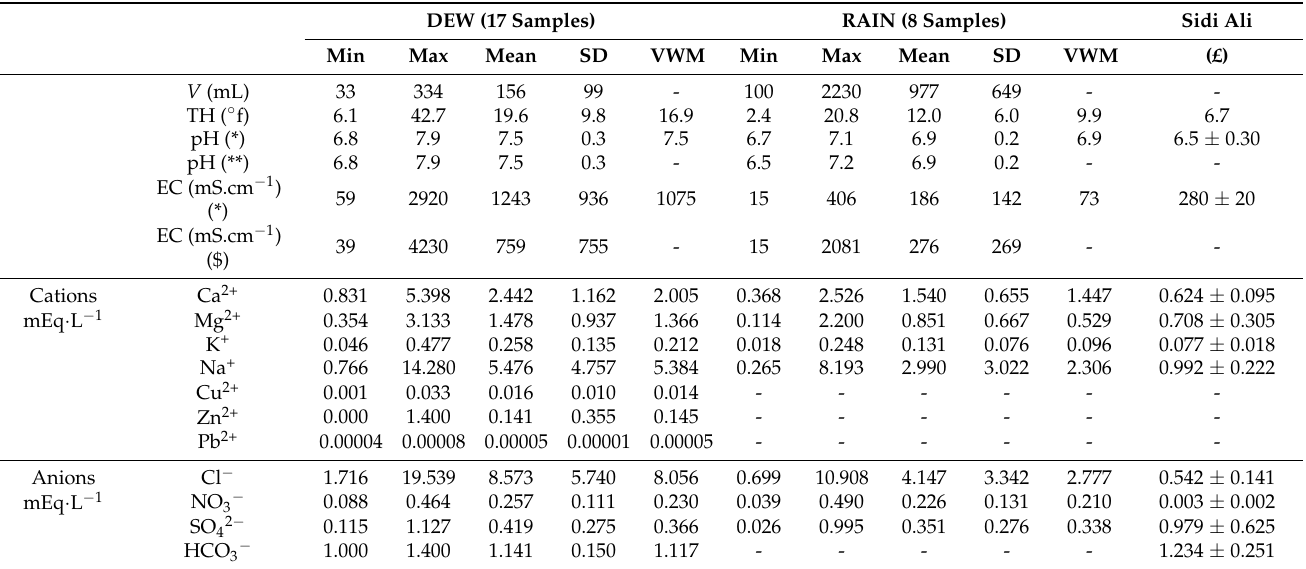
Table 6. Chemical analysis of dew and rain samples from Mirleft (Morocco, 1 May 2007–30 April 2008). The concentrations are expressed in mEq · L − 1 and are compared with a local spring water (“Sidi Ali”, produced at Oulm è s, Morocco). The electric conductivity is at 25 ◦ C. DEW (17 Samples) RAIN (8